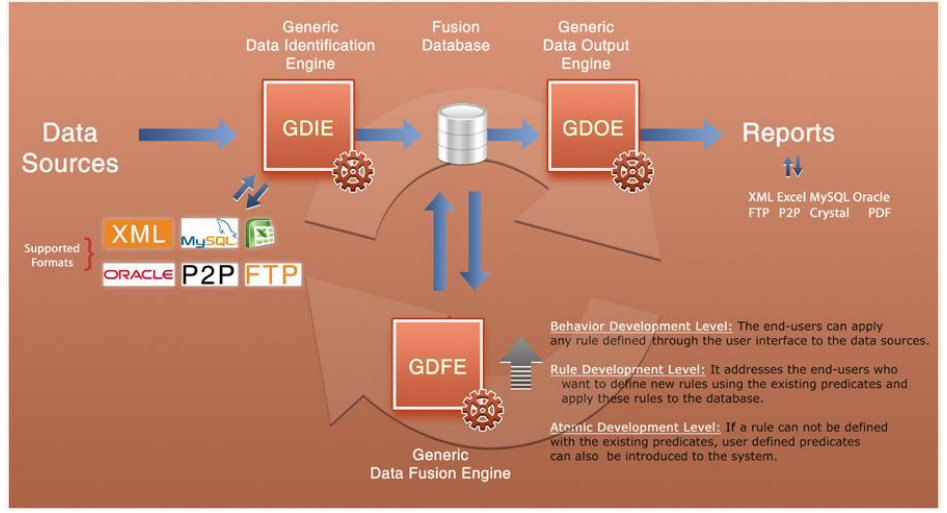
Figure 6. General structure of Generic Data Fusion